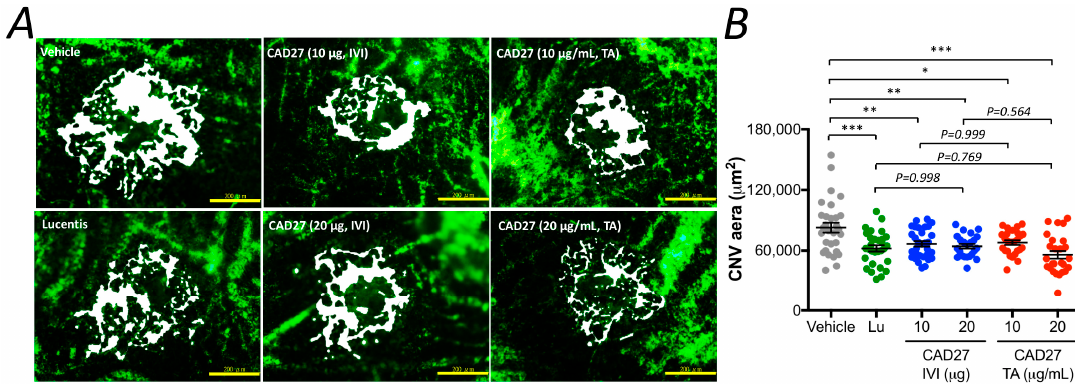
Figure 5. Flat-mount analysis of choroidal vascularity after an intravitreal or daily topical application of CAD27. Choroidal vascularity of laser-induced CNV lesions was examined by labeling using FITC- dextran. ( A ) Representative profile of FITC-dextran-positive blood vessels in choroidal flat-mounts at day 28 after treatment. Scale bar: 200 μ m. ( B ) FITC-dextran labeling CNV in the choroidal flat-mounts was quantified and data are presented as mean ± SEM ( n = 26–31 from 6 to 8 eyes) using one-way ANOVA followed by Tukey’s multiple comparisons test (* p < 0.05, ** p < 0.001, *** p < 0.0001). White area indicated the lesions of CNV in choroid flat-mount. Lu: Lucentis ® , IVI: intravitreal injection, TA: topical application.